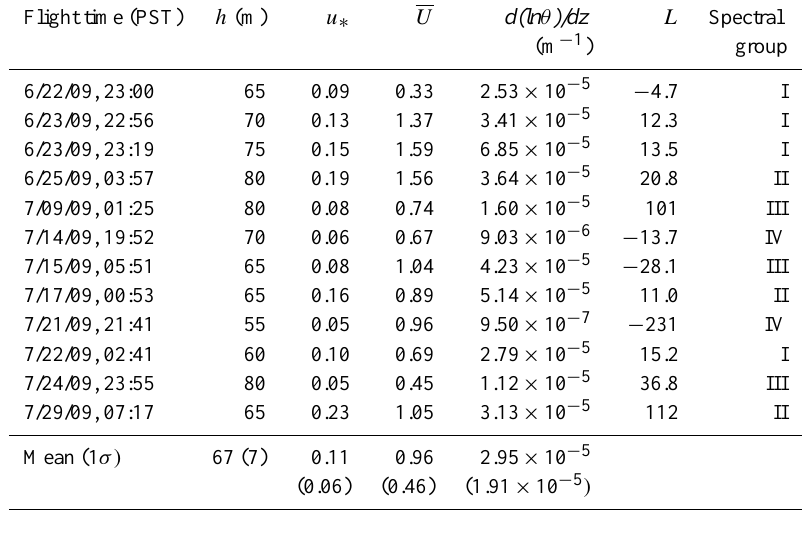
Table 4. Radio sonde launching time, observed nocturnal boundary layer height ( h) , surface friction velocity ( u ∗ ) , mean wind speed ( U) at z d of 6m, lapse rate of virtual potential temperature above h (d(ln θ) /dz), and Obukhov length (L) . Nighttime spectra of the v -wind component and temperature are grouped according to their shapes and peak spectral frequencies.